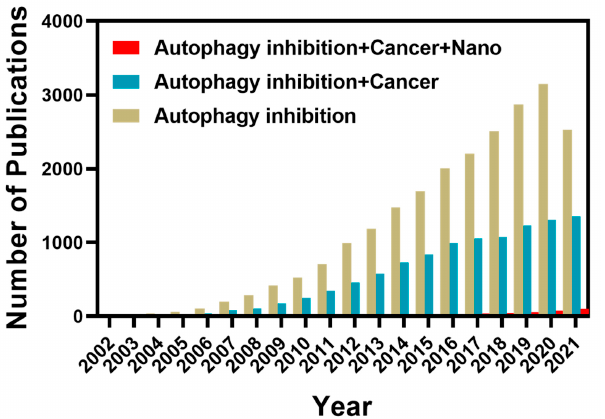
Figure 1. The publication record of Autophagy inhibition, Autophagy inhibition + Cancer therapy and Autophagy inhibition + Cancer therapy + Nano. (Source: Web of Science).